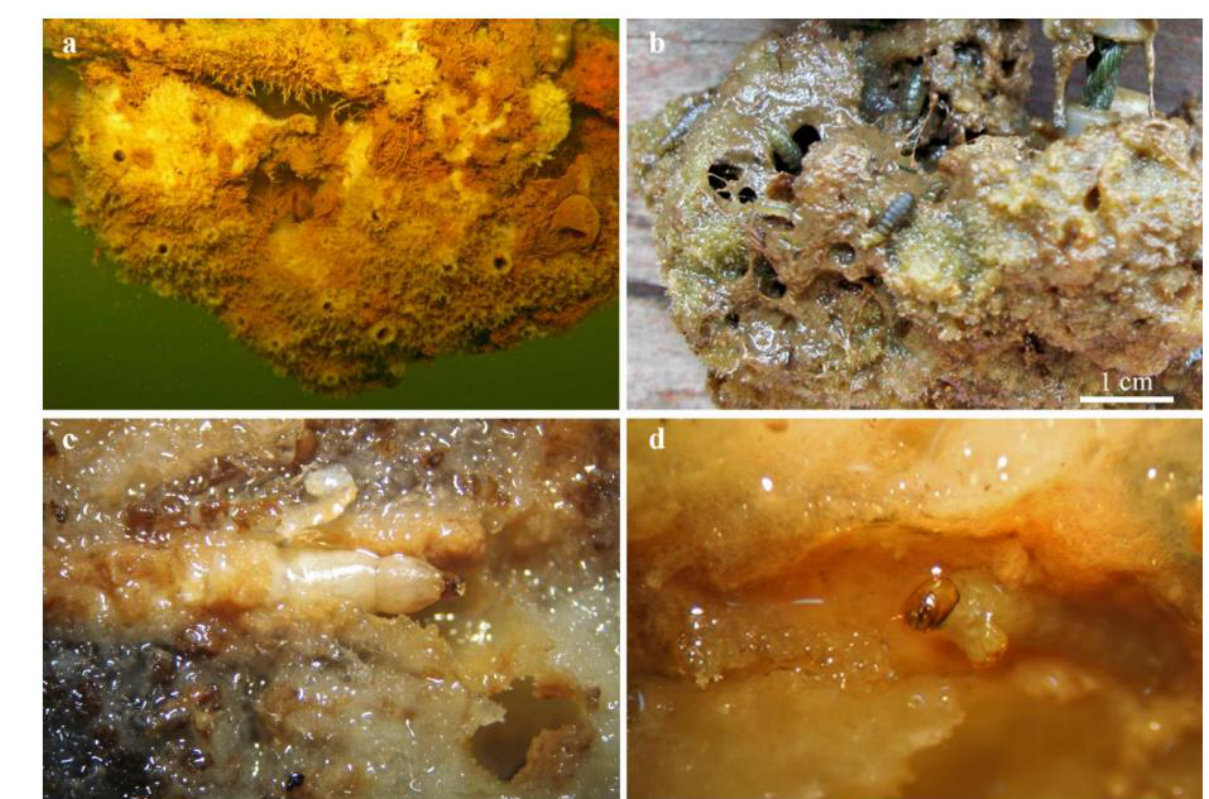
Figure 3. Corvospongilla siamensis (Porifera: Spongillida) in vivo settled on the raft artificial substrata of Pong River (Lower Mekong). ( a ) Outline of sponge conulose body surface with a variety of microhabitats at level of irregularly scattered crevices and ridges, and tube-like exhalant aquiferous openings (oscules). ( b ) Caddisfly larvae ( Amphipsyche meridiana , Hydropsychidae, Trichoptera) crawling on a cavity-rich surface of a greenish sponge. ( c , d ) Chironomid larvae (Chironomidae, Diptera) burrowing in the inner sponge body.